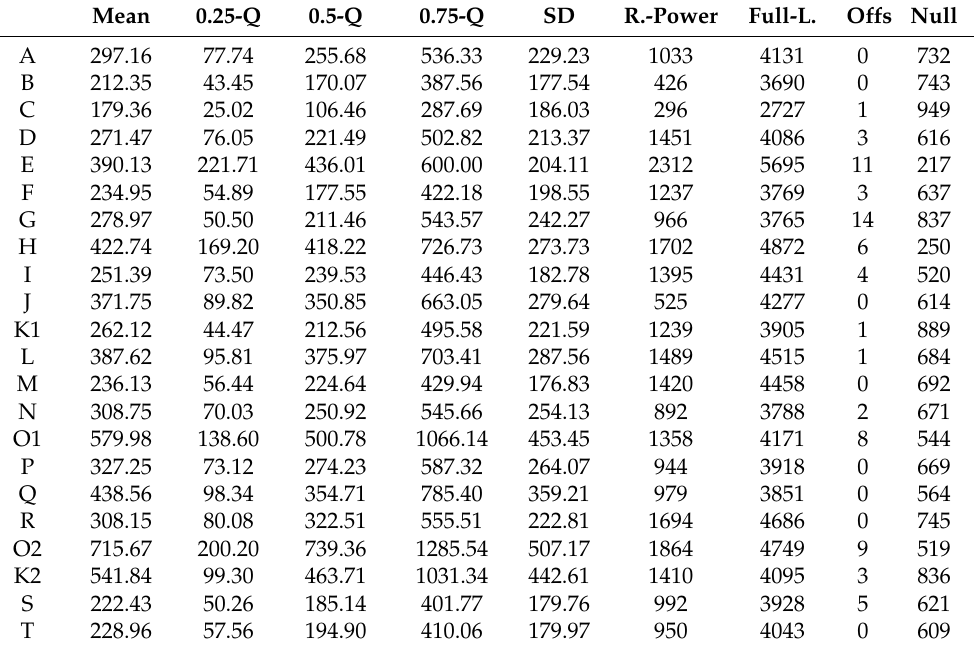
Table A5. Descriptive statistics of synthetic power production at the wind farms for the year